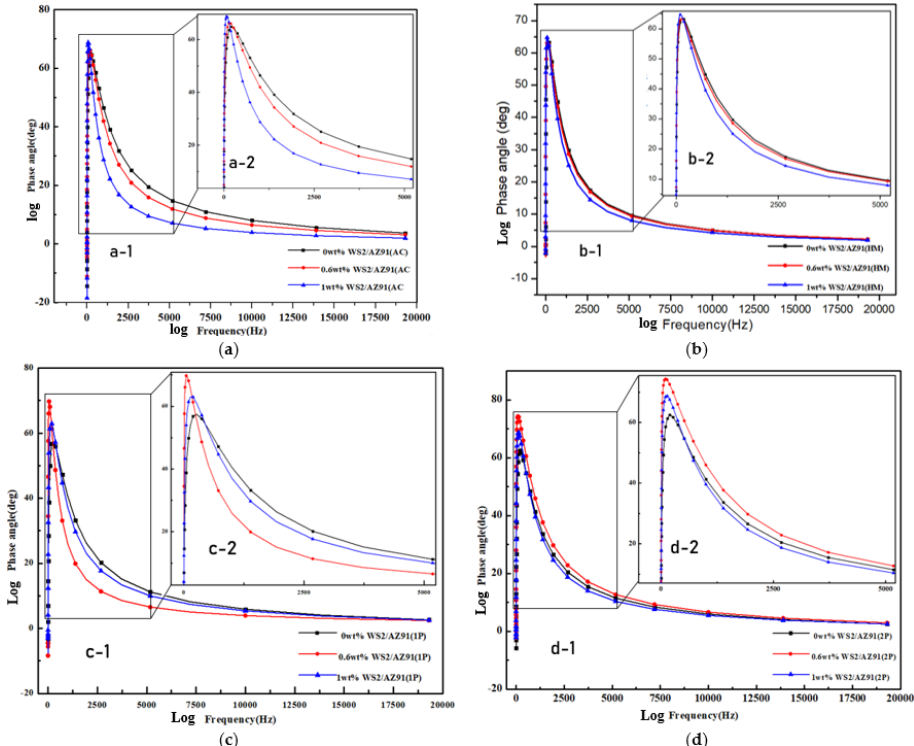
Figure 6. Bode diagrams for WS 2 /AZ91 composites in ( a ) as-cast, ( b ) homogenized, ( c ) one-pass ECAP, ( d ) two-pass